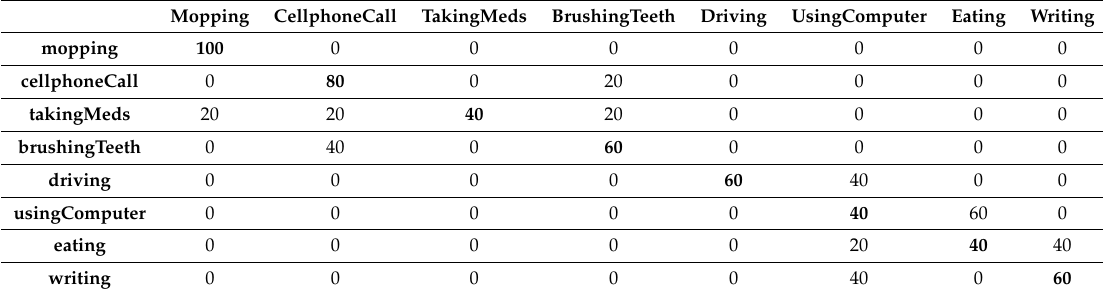
Table 2. Confusion matrix for Analysis 2 . The value in each cell represents the percentage that the row’s activity observation is matched to the column’s activity